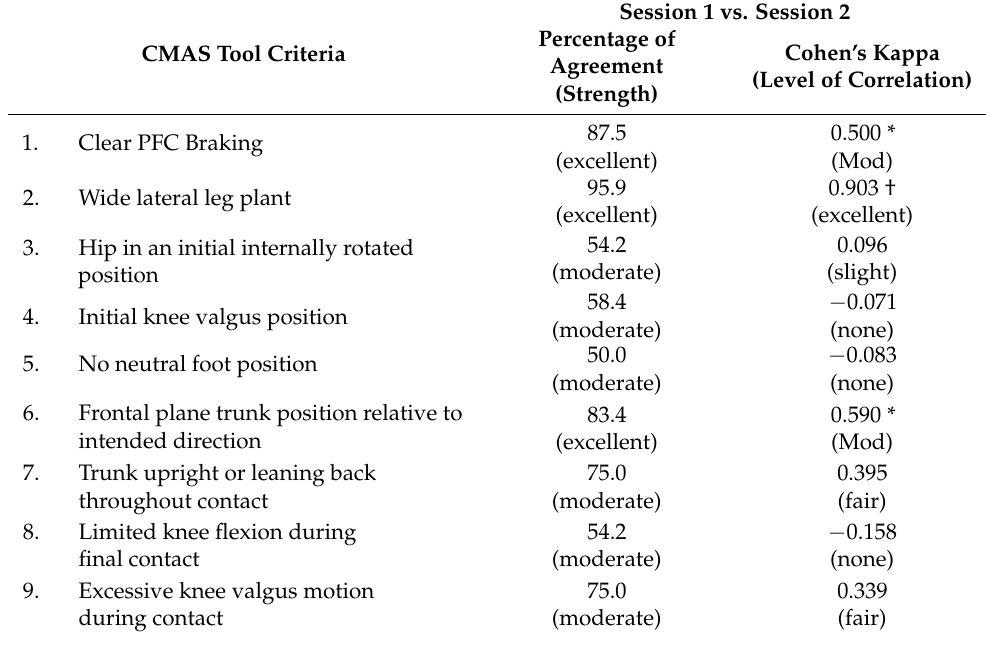
Table 4. Inter-session reliability (session 1 vs. session 2 analysed by rater 1) of CMAS tool criteria ( n = 24